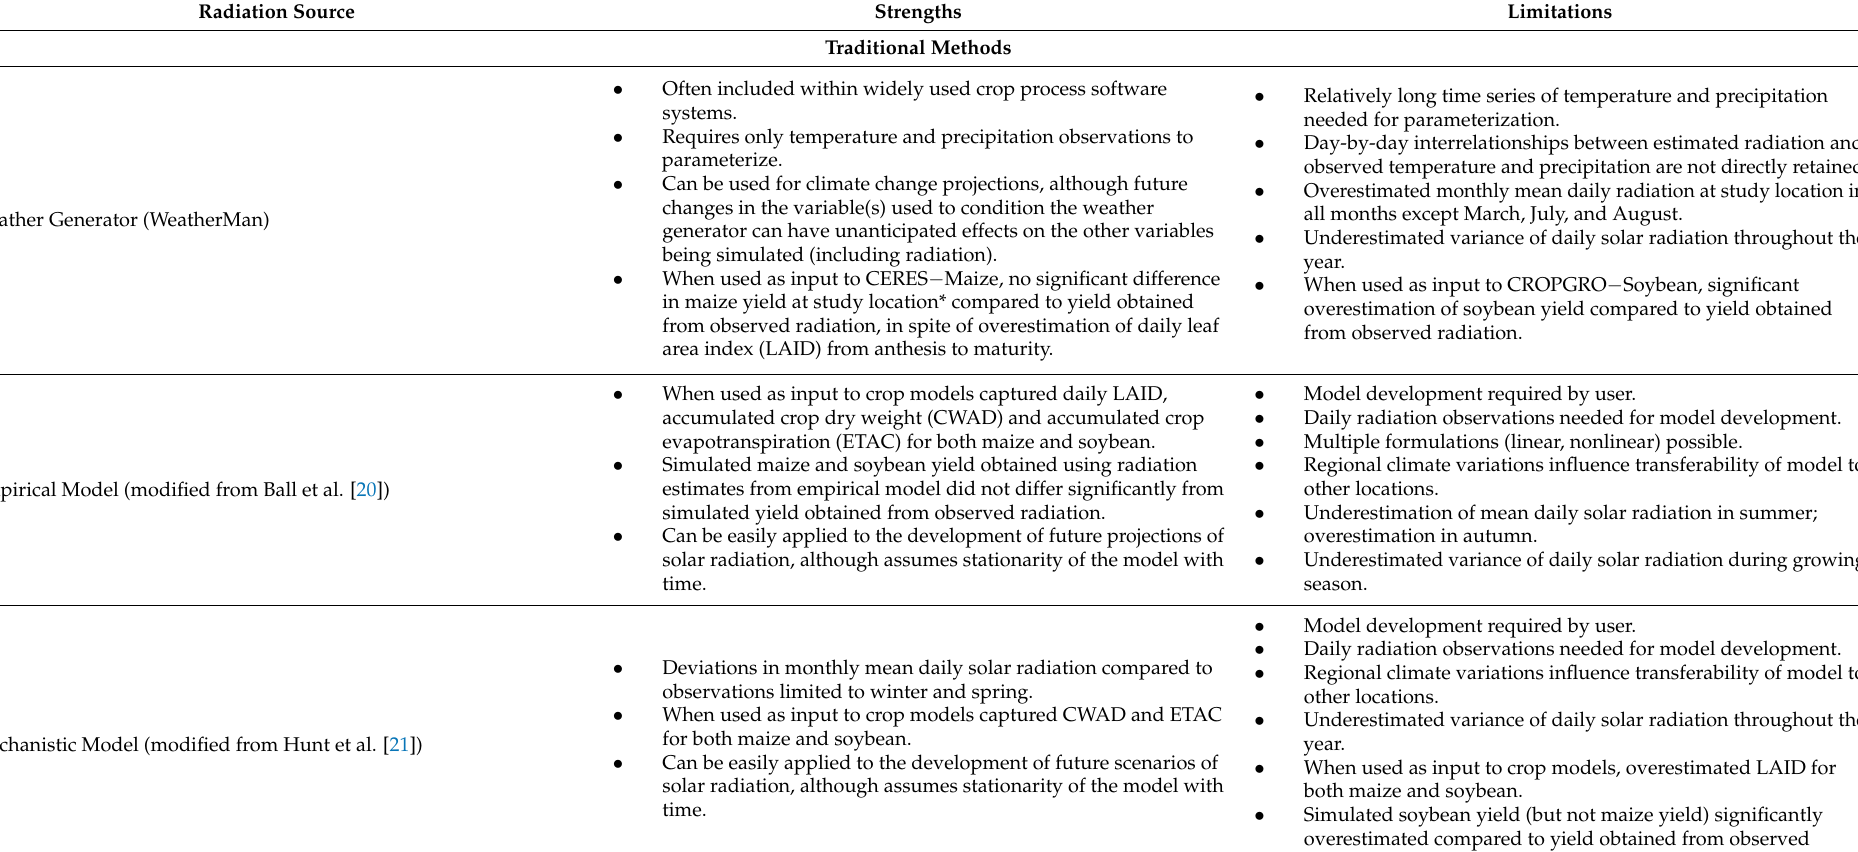
Table 4. Strengths and limitations of traditional and non-traditional sources of daily solar radiation